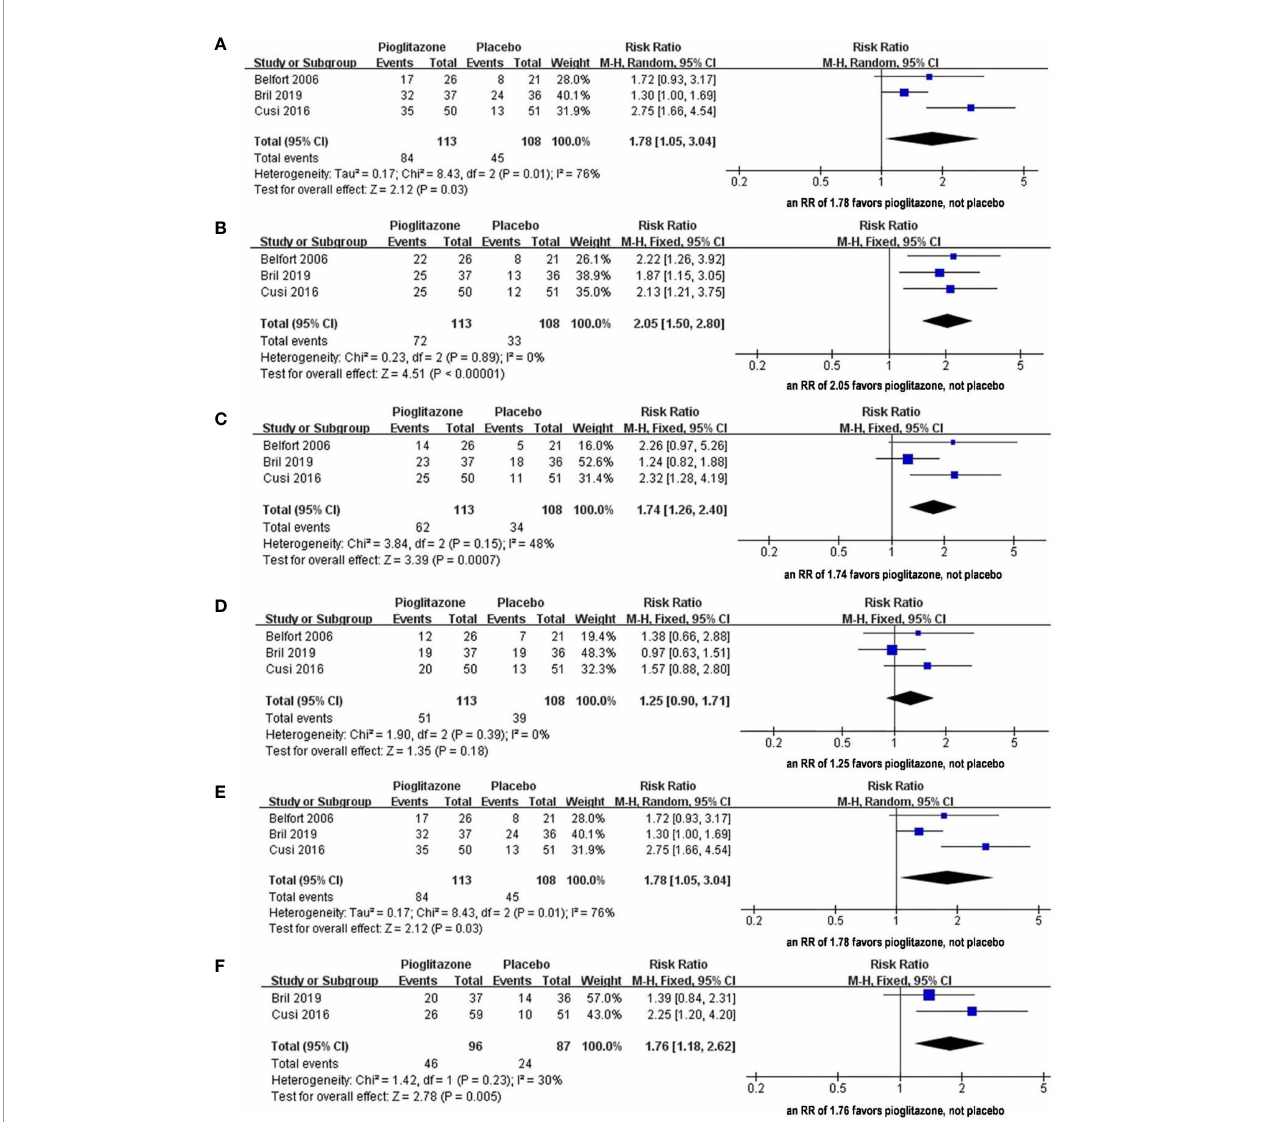
FIGURE 3 | The effect of pioglitazone in hepatic histologic scores (steatosis grade) with improvement of at least 1 grade (A) . The effect of pioglitazone in hepatic histologic scores (in fl ammation grade) with improvement of at least 1 grade (B) . The effect of pioglitazone in hepatic histologic scores (ballooning grade) with improvement of at least 1 grade (C) . The effect of pioglitazone in hepatic histologic scores ( fi brosis stage) with improvement of at least 1 grade (D) . The effect of pioglitazone in resolution of NASH without worsening of fi brosis (E) . The effect of pioglitazone in reduction of at least 2 points in hepatic histologic scores (from two different parameters) (F)